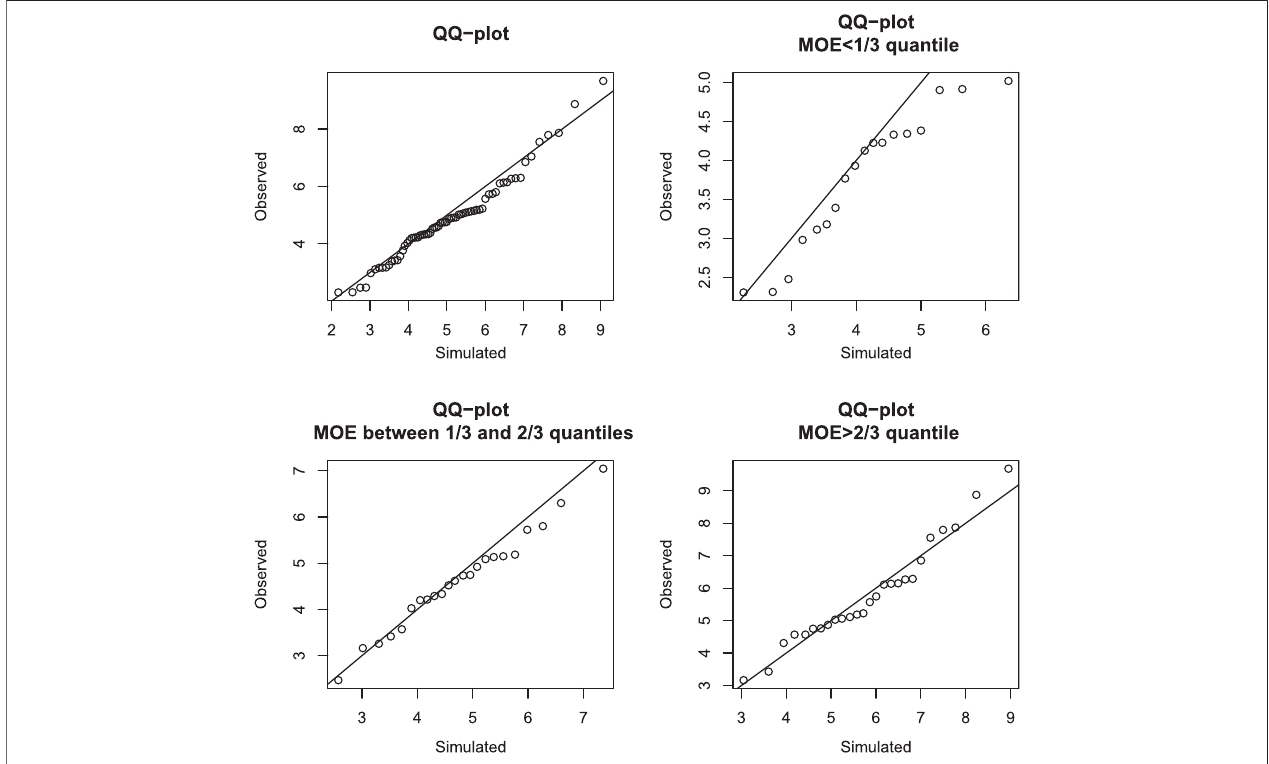
FIGURE 5 | Gaussian copula model and R20. Q-Q plot of observed residual UTS against simulated UTS with the identity line, given MOR greater than its 20 th quantile and MOE in different quantile intervals.